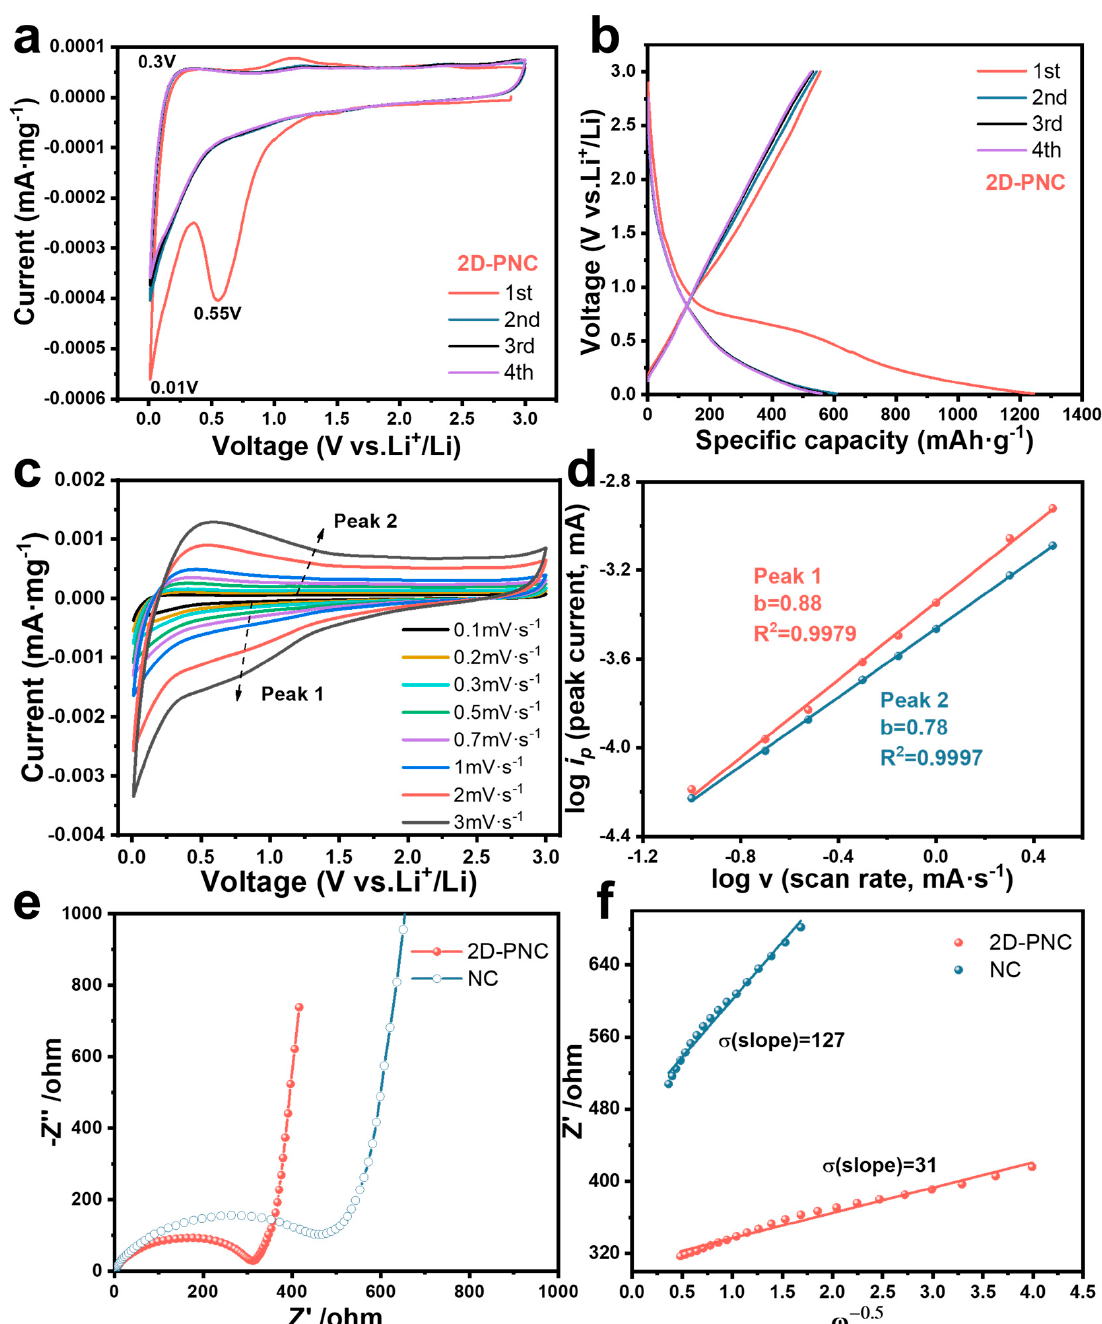
Figure 4. ( a ) CV profiles of the first four cycles at 0.1 mV s − 1 of 2D-PNC. ( b ) Charge and discharge voltage profiles for the first four cycles at 0.2 A g − 1 of 2D-PNC. ( c ) CV profiles at various scan rates of 2D-PNC, and ( d ) the corresponding linear fits of 2D-PNC. ( e , f ) Nyquist plots and the linear fitting plots of Z ′ vs. W − 0.5 of 2D-PNC.